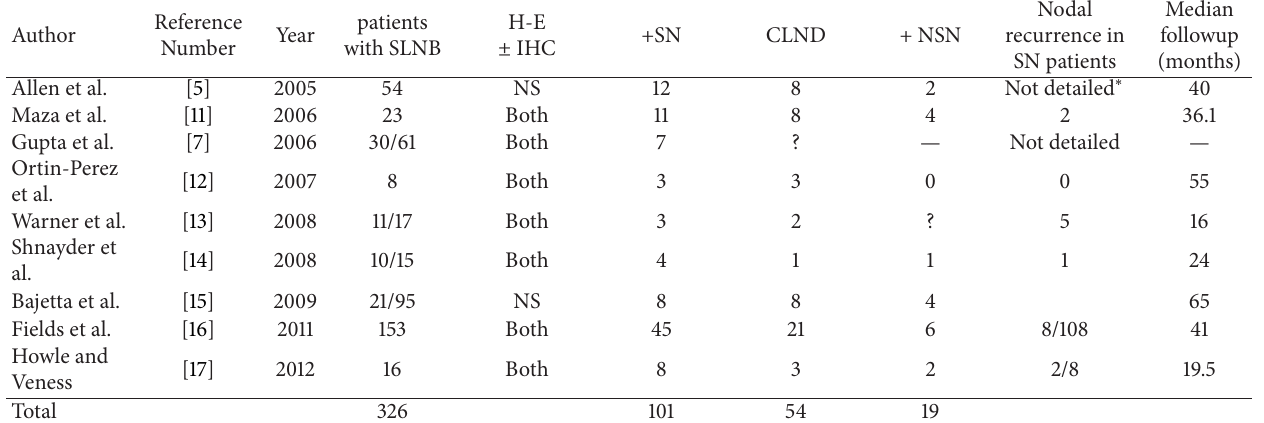
Table 3: Review of studies with sentinel lymph node biopsy in patients with